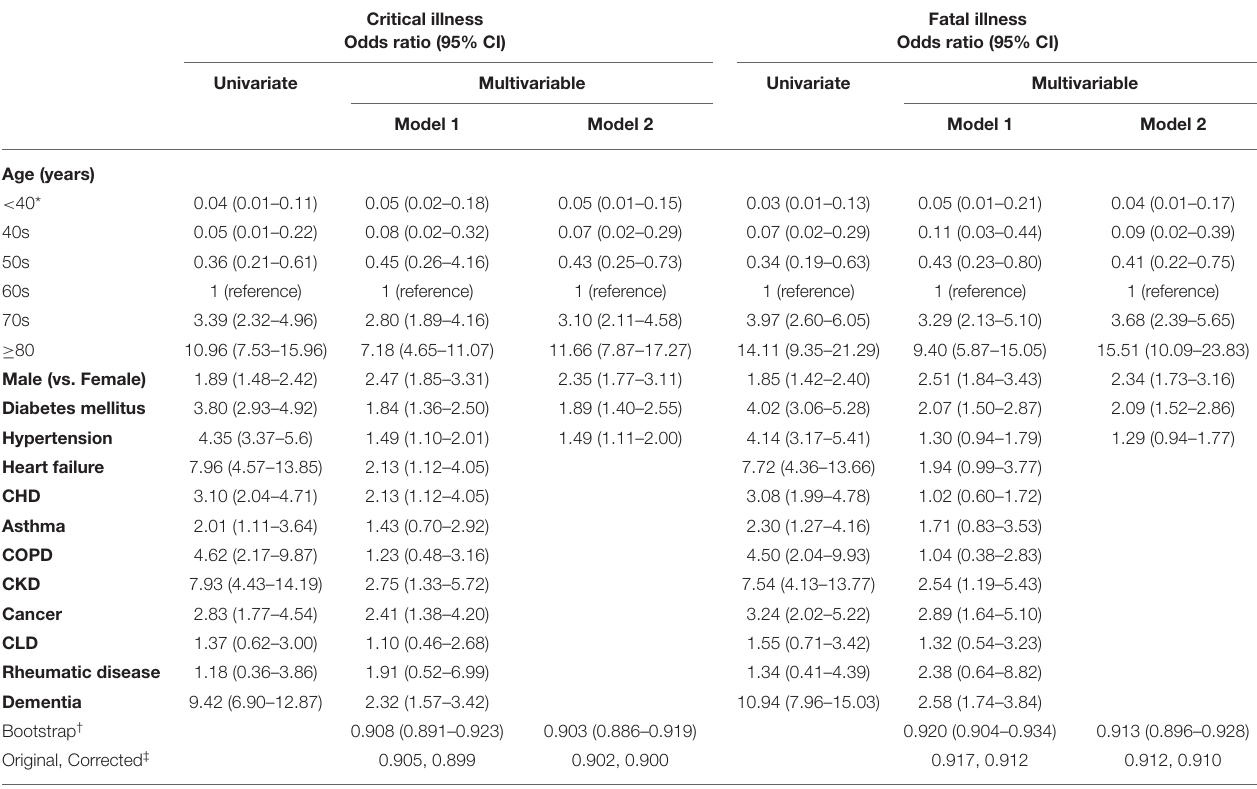
TABLE 2 | Logistic analyses and c-statistics for critical and fatal illness.